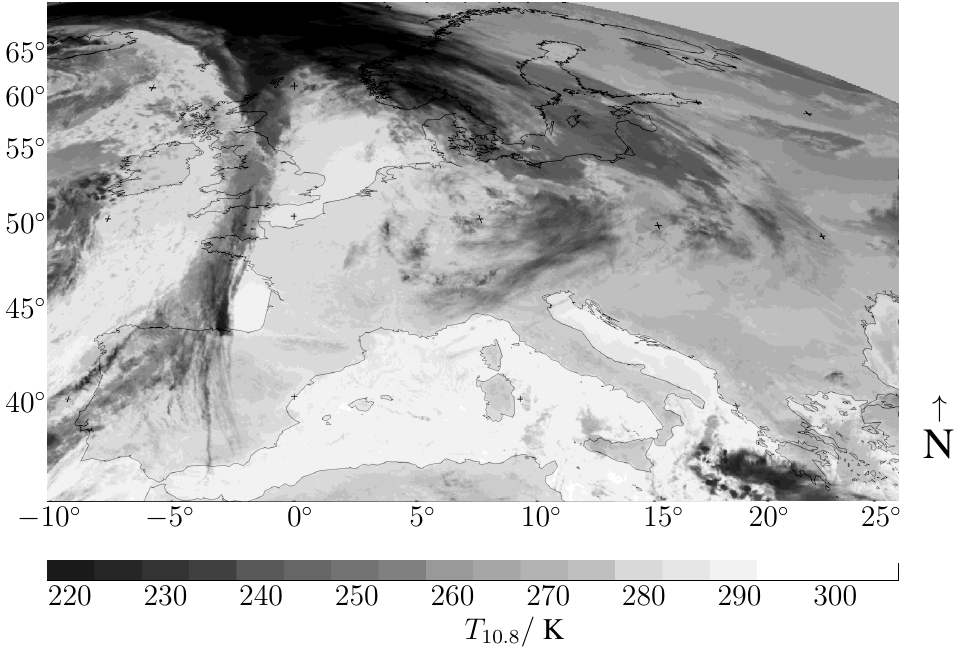
Figure 2. Brightness temperature T